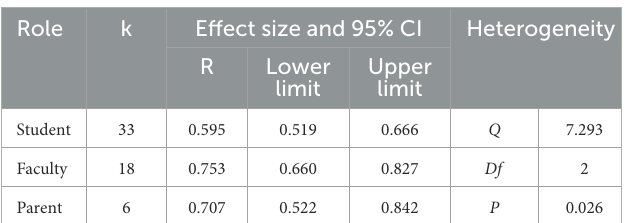
TABLE 5 Satisfaction with online education among students, faculty, and parents before and after the COVID-19 outbreak and role moderator